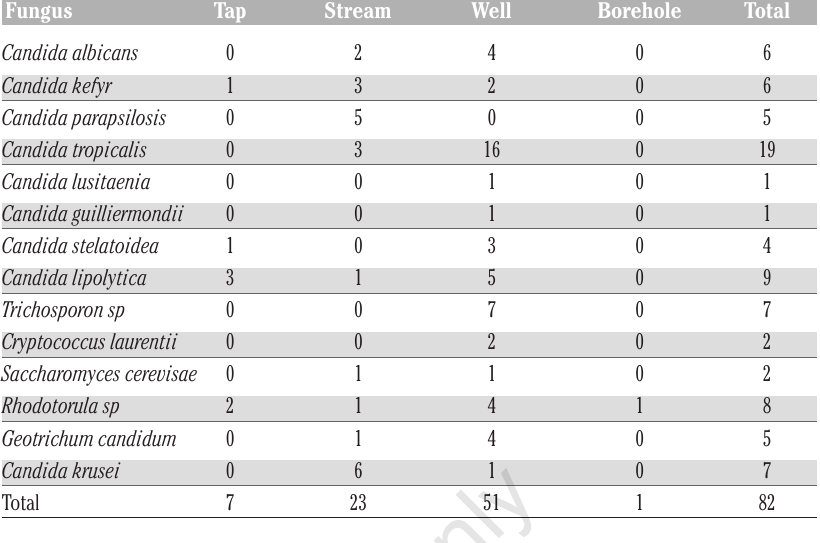
Table 3. Distribution of yeasts and yeast-like fungi isolated from various water sources examined. Fungus